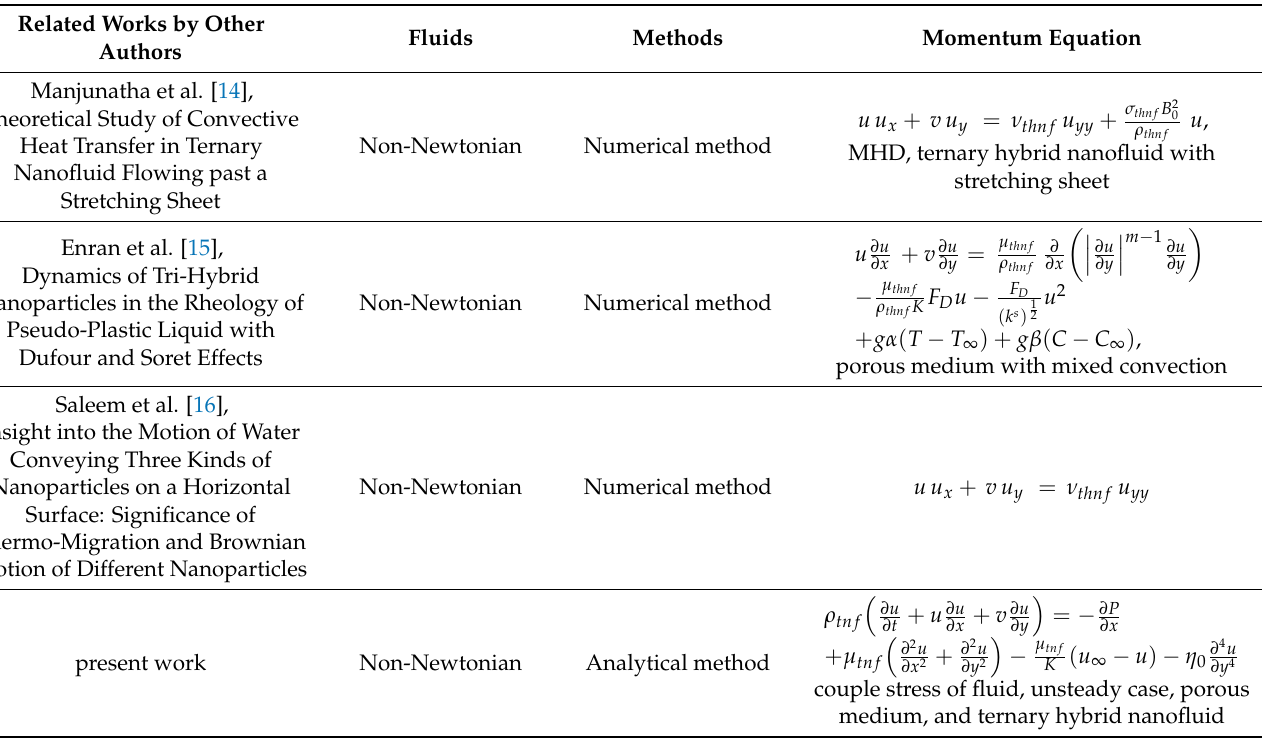
Table 2. Comparing the